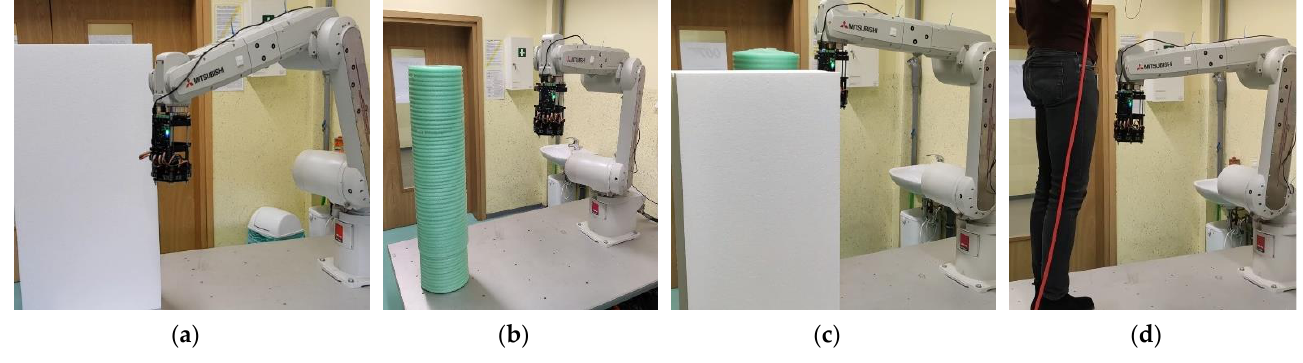
Figure 10. Mitsubishi robot with the mounted head while avoiding an obstacle: ( a ) a cuboid block; ( b ) a cylinder block; ( c ) multiple obstacles; ( d ) a human. Table 2. Results of experimental research for the task of robot TCP positioning at a given point and avoiding an obstacle.